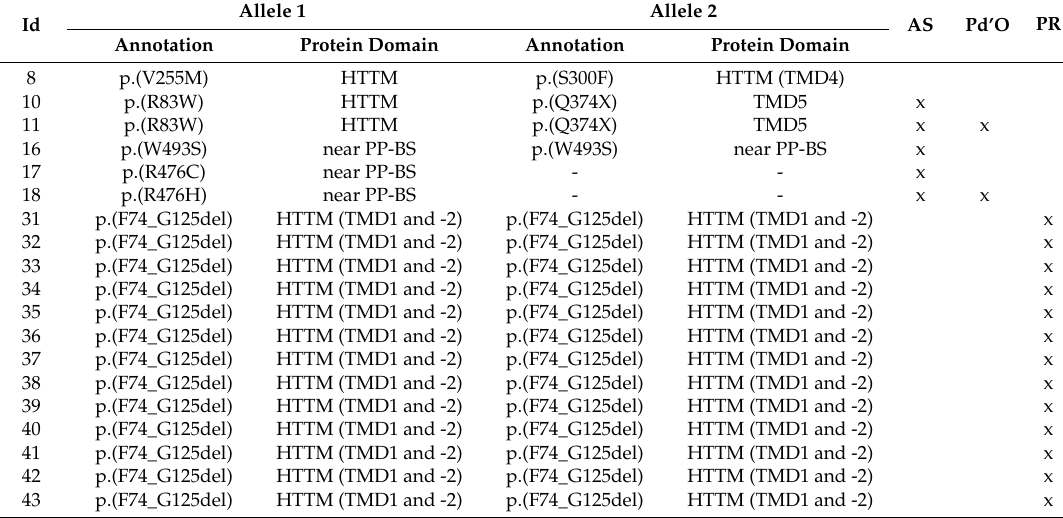
Table 6. Eye phenotype in patients with GGCX mutations. This table gives an overview of all patients in the analyzed cohort with ophthalmological manifestations. For each patient, the GGCX mutations on both alleles and the affected protein domain are stated (protein annotation). Further, a brief overview of the eye symptoms is